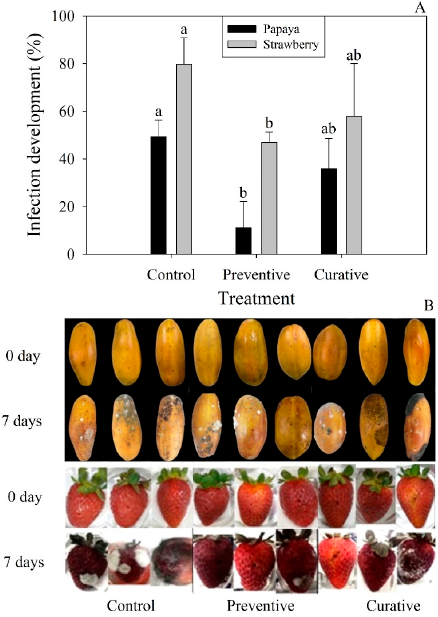
Figure 2. In vivo antifungal activity of garlic peel extracts against C. gloeosporioides and B. cinerea inoculated on papaya and strawberry after 7 days of storage (25 ± 2 °C). ( A ) Percentage of infection. ( B ) Fungi development. Different letters (a, b) indicate significant statistical differences ( p < 0.05).